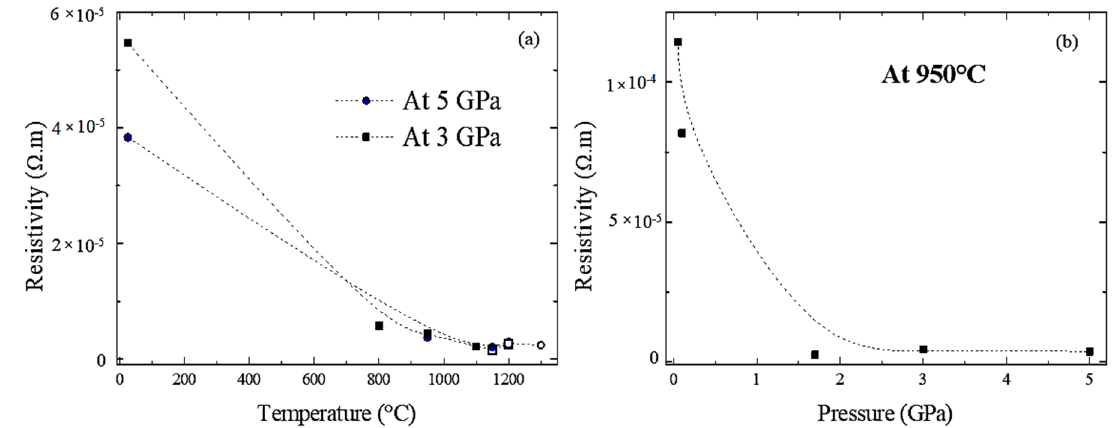
Figure 4. Resistivity of MgB 2 as a function of ( a ) temperature at 3 and 5 GPa and ( b ) pressure at 950 °C.